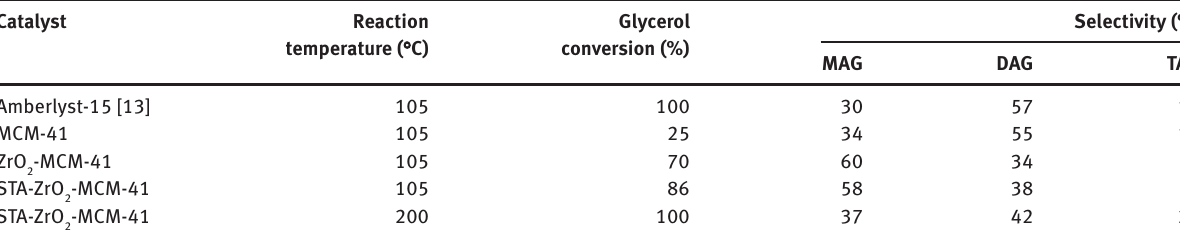
Table 3: Catalytic activities of the catalysts (reaction time, 245 min). Catalyst Reaction